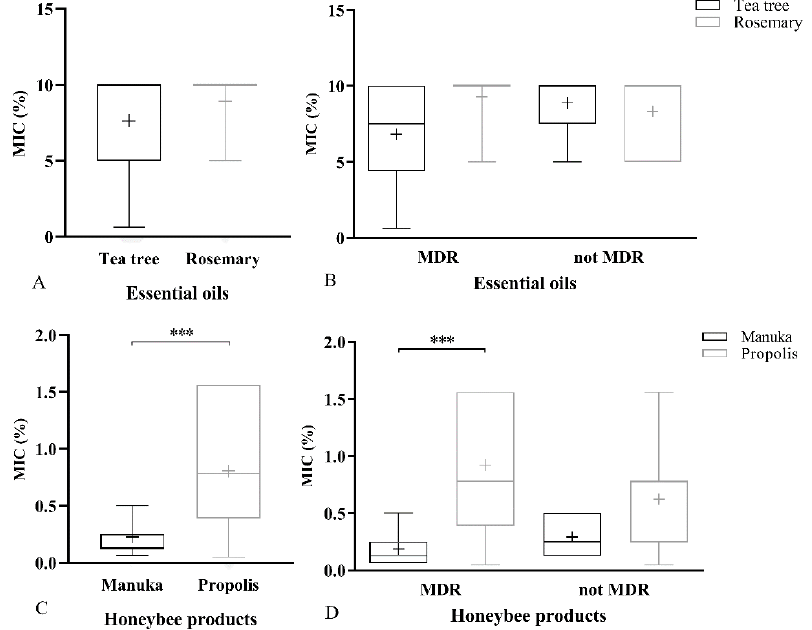
Figure 2. Minimum inhibitory concentration (MIC) values for all the natural products used. Box-plot was used to visualize the dataset, min to max are expressed by vertical lines, while median and